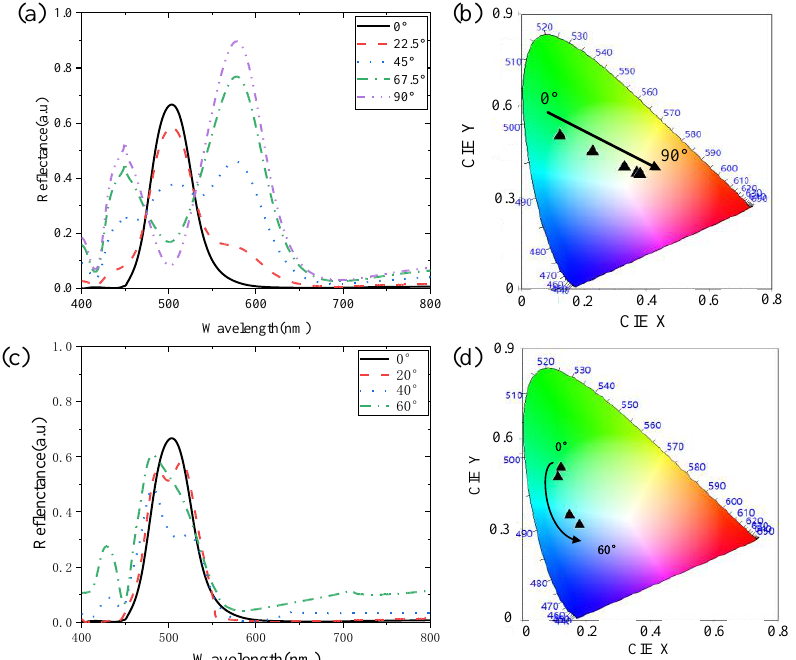
Figure 5. ( a ) The simulated reflection spectrum, with increasing polarization angle from 0° to 90°, and ( b ) the corresponding CIE1931 chromaticity diagram. ( c ) The simulated reflection spectrum with increasing y -incident angle from 0° to 60°, and ( d ) the corresponding CIE1931 chromaticity